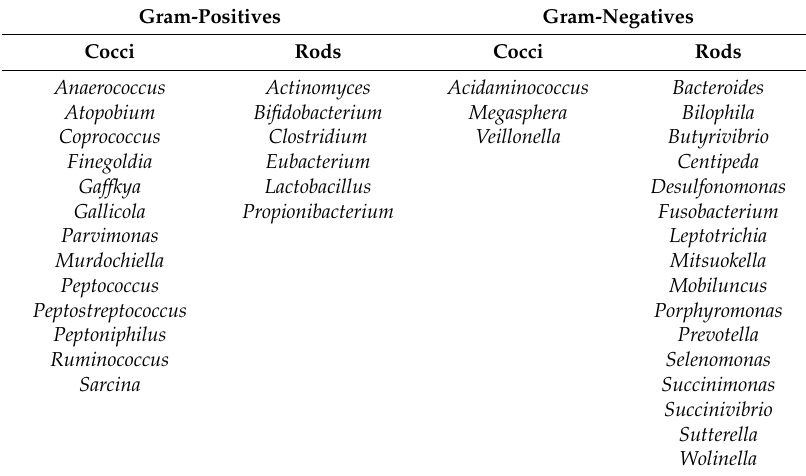
Table 1. Summary of the most important genera of anaerobic bacteria